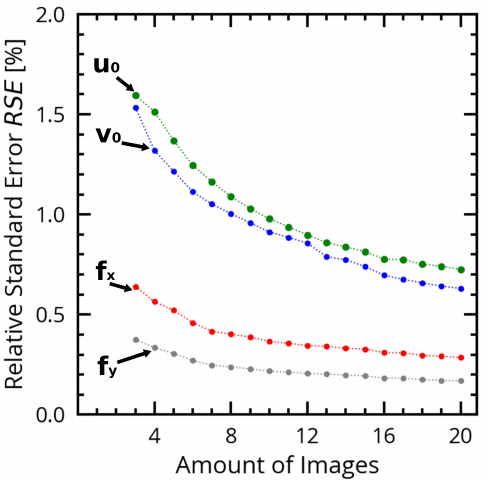
Figure 3. Relative Standard Error (RSE) of the focal length camera parameters ( f x , f y ) and the principal point camera parameter ( u 0 , v 0 ) for the parameter estimation in Figure 1 with respect to the number of images in the calibration dataset (f = 25 mm). The RSE decreases with the amount of image planes used for the parameter estimation. All RSEs show a small value and therefore a good estimation accuracy